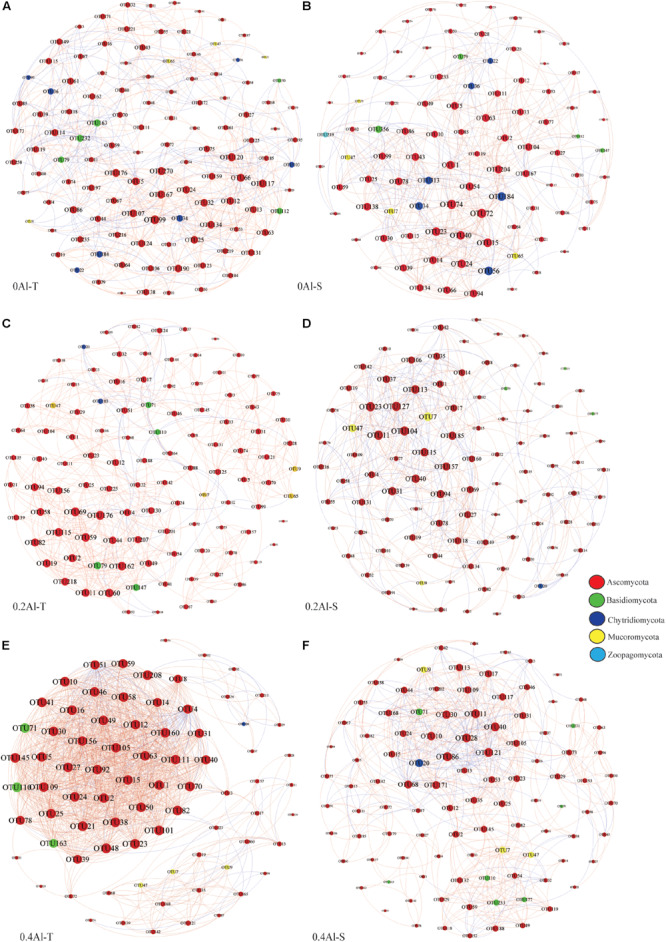
Co-occurrence network of the rhizosphere fungal community for different Al concentrations and soybean genotypes, i.e., 0 Al-T (A), 0 Al-S (B), 0.2 Al-T (C), 0.2 Al-S (D), 0.4 Al-T (E) and 0.4 Al-S (F). Nodes represent OTUs colored-coded by phyla and scaled proportional to the number of connections (node degree). Connections were drawn at r > 0.8 (positive correlations, red) or r < –0.8 (negative correlations, blue) and P < 0.05. Al-T: Al-tolerant soybean genotypes; Al-S: Al-sensitive soybean genotypes.